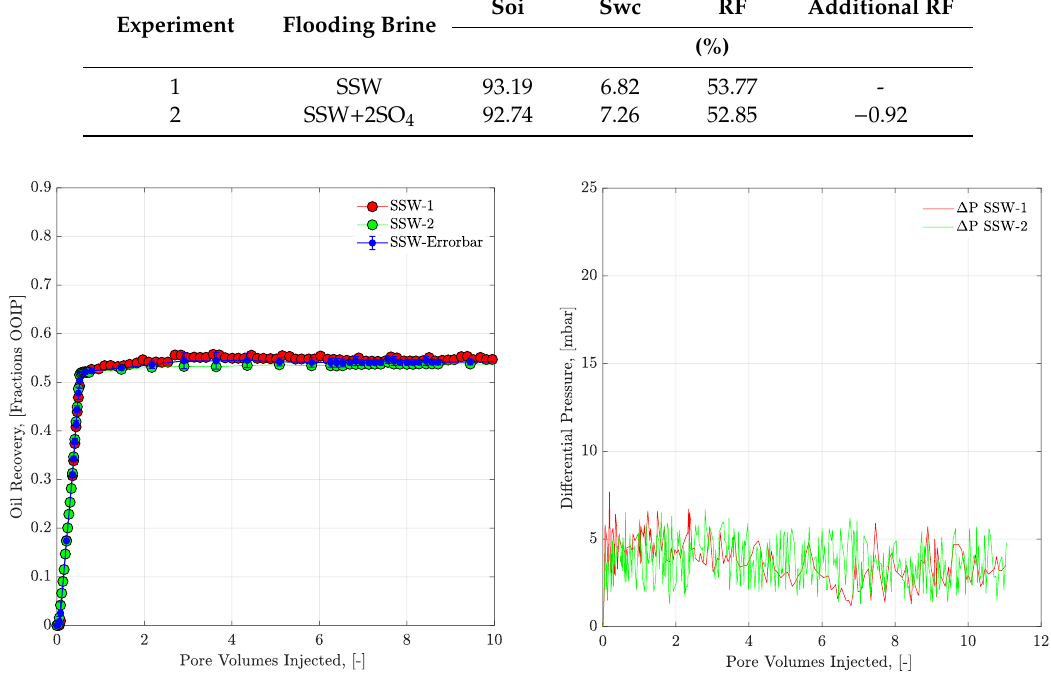
Figure 14. Oil recovery and pressure drop versus PV injected for water-wet artificial structure micromodel. SSW injection is performed as the secondary mode for both flooding experiments. Table 11. Summary of artificial structure water-wet micromodel with initial oil saturation, which connate water saturation and final oil recovery factors.